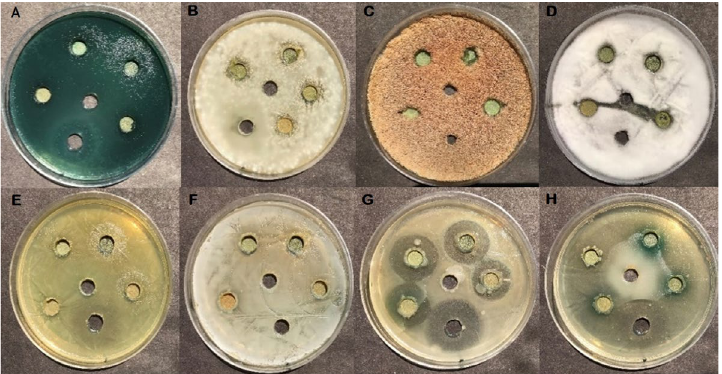
Fig. 2. Inhibition zone against the bacterial and fungal pathogen in 20mg/ml concentration of Usnea longissimi. A) Pseudomonas aeruginosa B) Candida albicans C) Aspergillus niger D) Fusarium oxysporium E) Staphylococcus aureus F) Streptococcus mutans G) Escherichia coli H) Agrobacterium